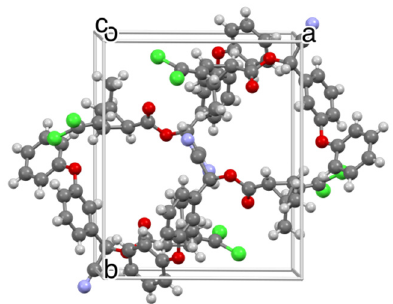
Figure 4. Crystal structure of α -cypermethrin Form